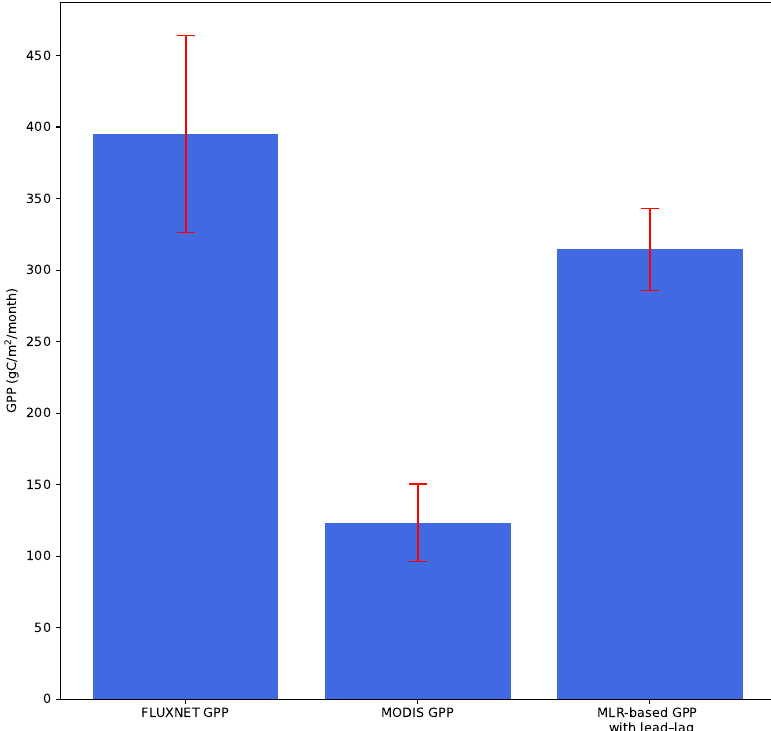
Figure 10. Mean total GPP (gC/m 2 /month) within a CLM grid box surrounding US-ARM, US-AR1 and US-AR2 stations in JJA 2007–2012. Total GPP is calculated as a sum of C3 non-arctic grass GPP, C4 grass GPP and C3 crop